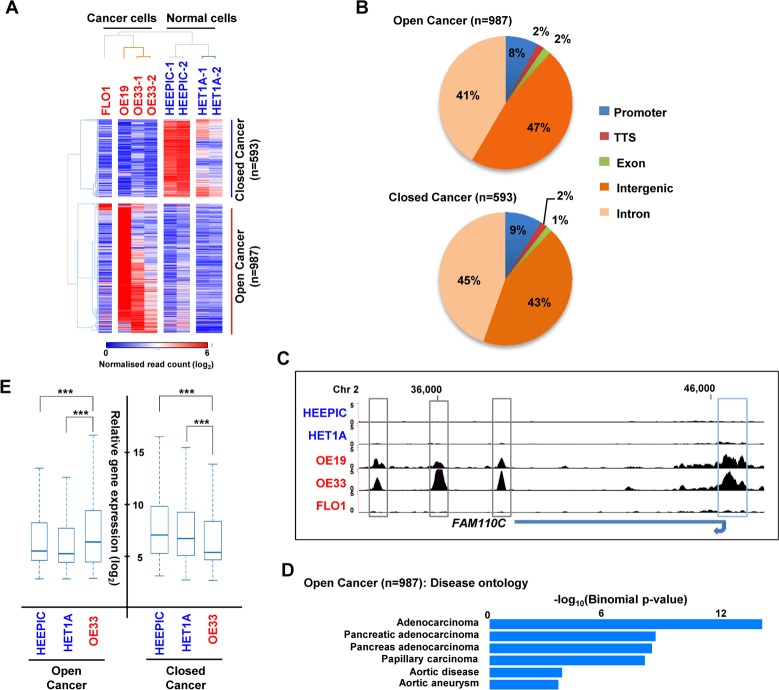
ATAC-seq reveals open chromatin regulatory regions in OAC cell lines.(A) Heatmap of normalised Tn5 cleavage events (log2) in 500 bp regions surrounding the summits of the significant differentially accessible regions (+/- linear fivefold change, p<0.05) between non-cancer and cancer cell lines. Replicate data are shown for three of the cell lines. Data are hierarchical clustered using 1-Pearson’s correlation and grouped according to either more “open” or “closed” in cancer. (B) Pie chart showing the genomic distribution of the differentially accessible regions (promoter = +/- 1 kb from TSS). (C) UCSC browser track showing open chromatin regions at the FAM110C locus in the indicated cell lines. Intergenic (grey boxes) and promoter proximal (blue boxes) peaks are highlighted. (D) The top 6 gene ontology terms from the disease category of the genes associated with the differentially accessible regions more open in cancer cells. (E) Box plots of expression (log2) from microarray data of the nearest gene to differentially accessible peaks in the indicated cell lines. Horizontal line indicates median. *** = P-value <0.001 (t test).